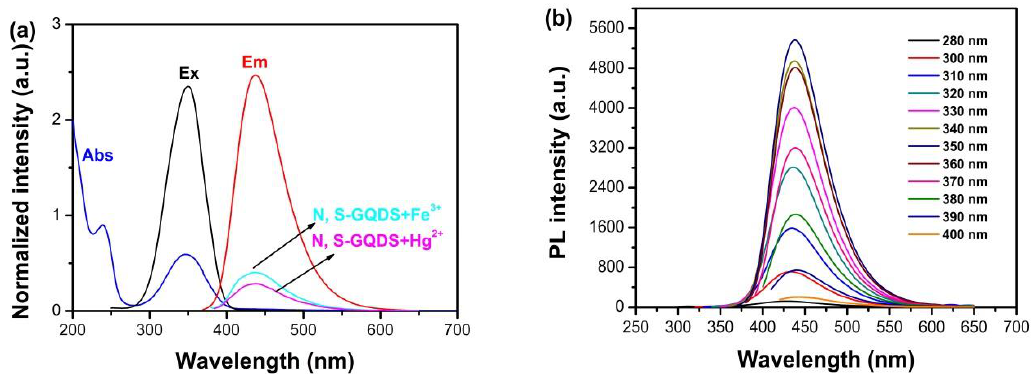
Figure 7. ( a ) UV-vis absorption, fluorescence excitation, and fluorescence emission spectra of N, S-GQDs; ( b ) the excitation dependent photoluminescence (PL) emission spectra of N, S-GQDs.